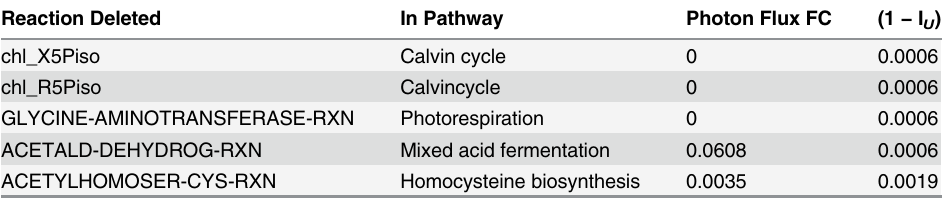
Table 1. Some of the reactions with low (1 − I U ) values and negligible photon fold change are shown here. These reactions can be bypassed by the cellular metabolism to produce biomass. ‘ chl_ ’ indicates a chloroplastic reaction; while the rests are cytosolic. From top to bottom the reactions are xylulose 5 phosphate isomerase, ribose-5-phosphate isomerase, glycine-aminotransferase, acetaldehyde dehydrogenase and O- acetylhomoserine